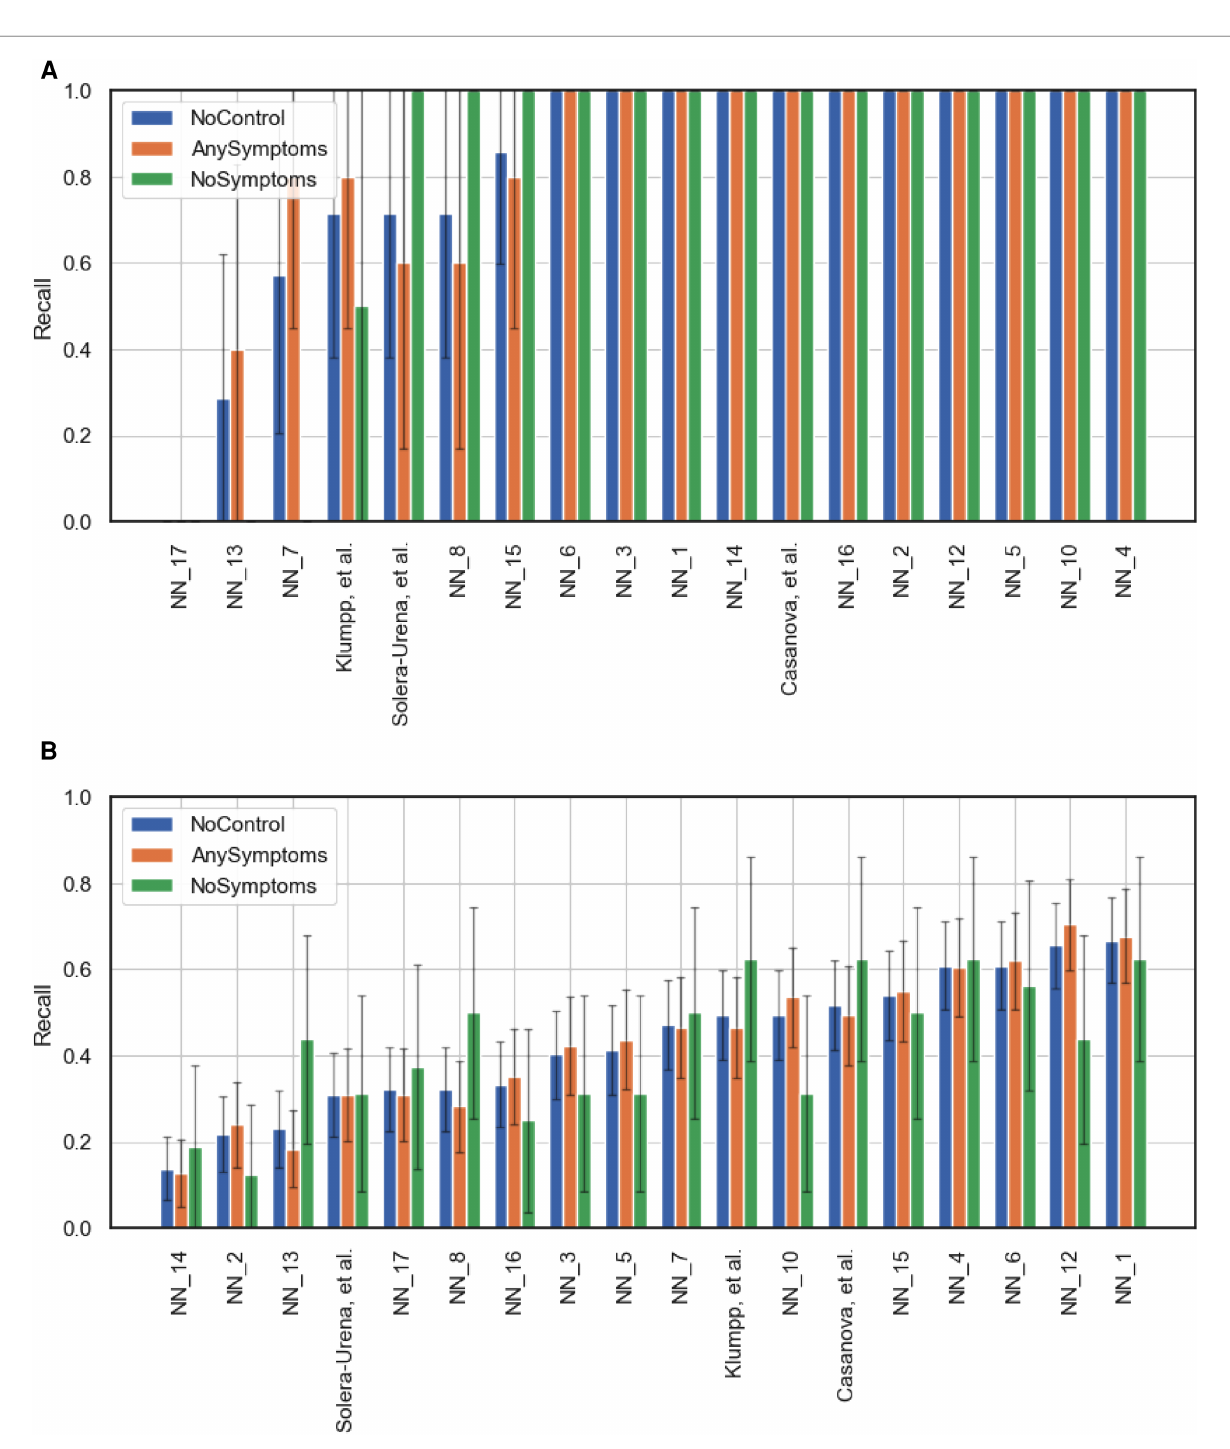
FIGURE A7 Team performance on two curated test sets from the COVID-19 Speech Sub-Challenge. ( A ) Controls for test samples with a sample rate of greater than 12kHz and ( B ) controls for test samples with a sample rate of 12kHz and below. The metric reported is recall for positive cases. 95% con fi dence intervals are shown, calculated via the normal approximation